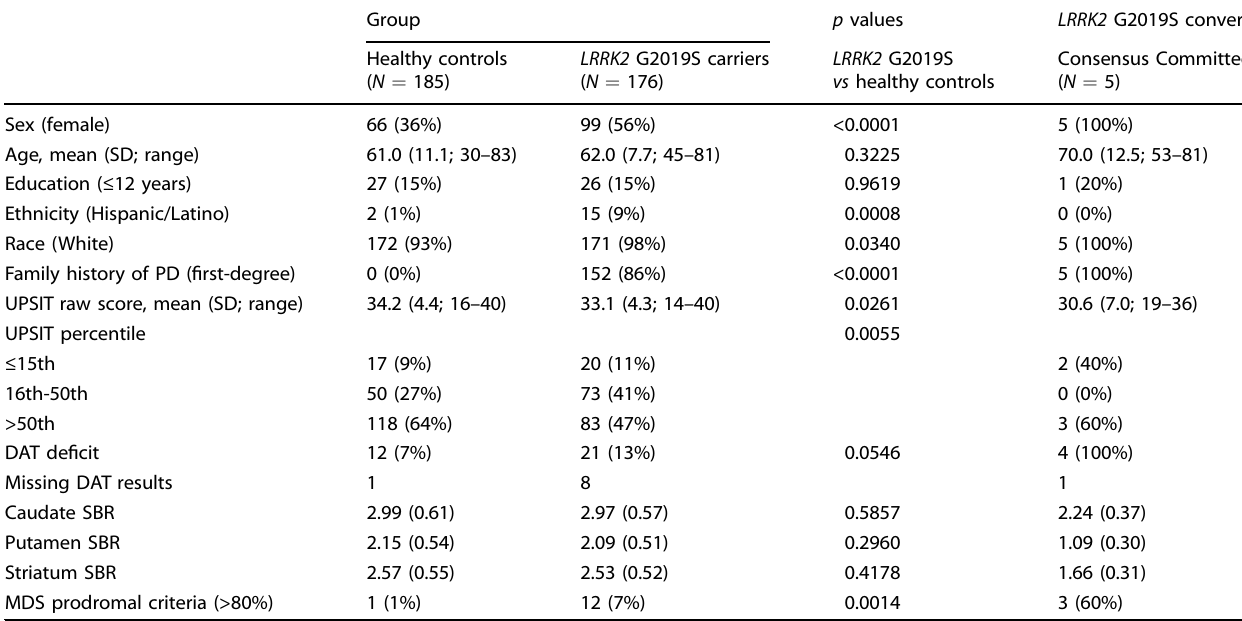
Table 1. Demographics and baseline